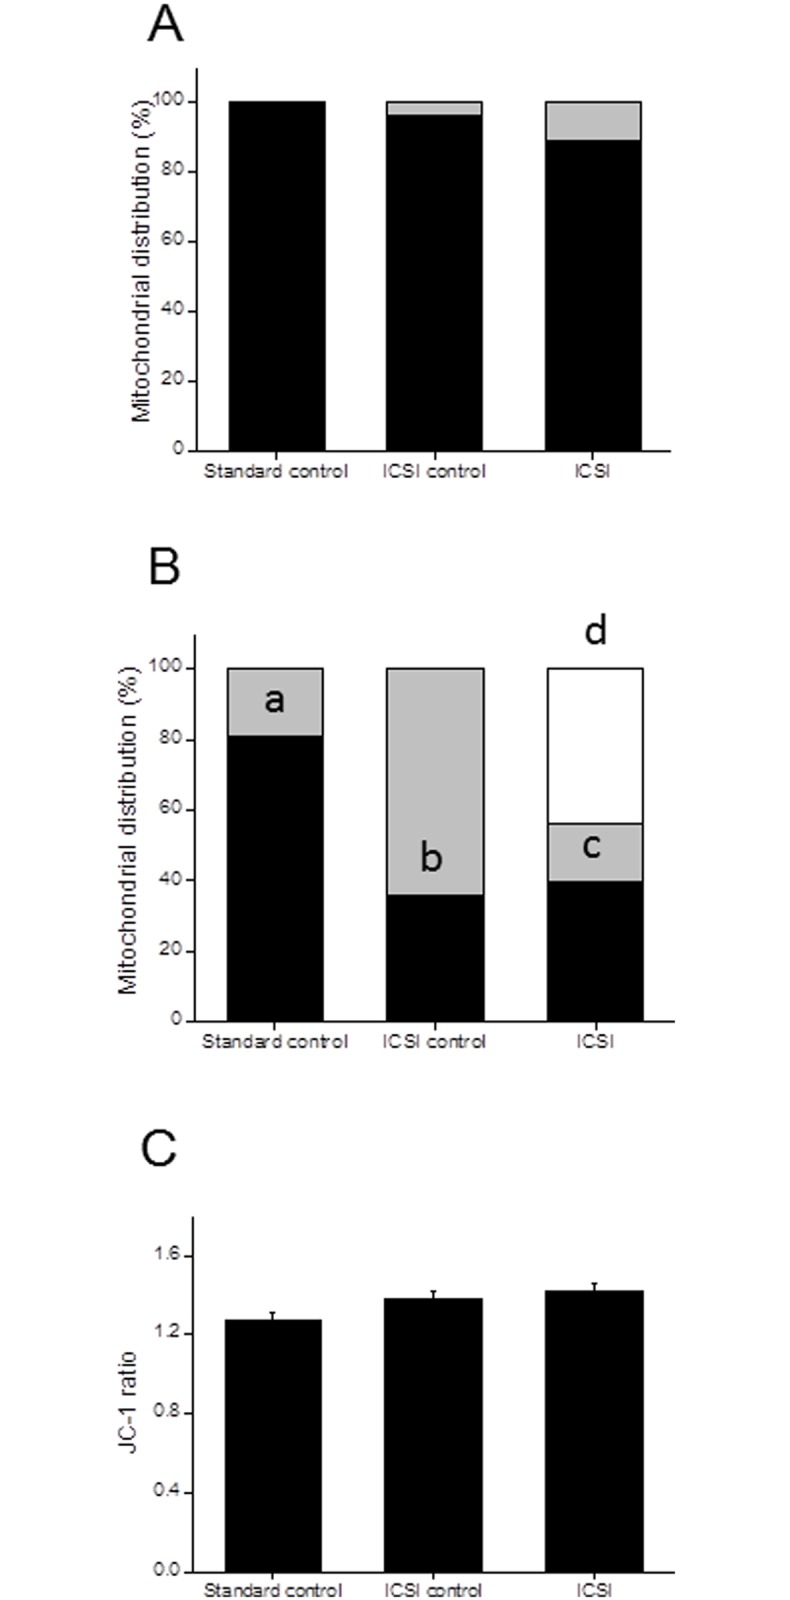
Mitochondrial distribution and activity as measured by Rhodamine 123 and JC1 staining of oocytes.A. Oocytes retrieved from superovulated mice, subjected to mock ICSI were assessed for mitochondrial distribution. The percentage of oocytes displaying uniform (closed bar); and aggregated (grey bar) distribution in standard control (N = 28), ICSI control (N = 49) and ICSI group (N = 36), was determined. B. In vitro matured metaphase II oocytes, subjected to mock ICSI were evaluated for mitochondrial distribution. The percentage of oocytes displaying uniform (closed bar); aggregated (grey bar) and peripheral (open bar) distribution in standard control (N = 33), ICSI control (N = 33) and ICSI group (N = 32), was determined. aP <0.05: Uniform distribution pattern in standard control of figure A Vs Standard control in figure B. bP < 0.001: Standard control Vs ICSI control. cP < 0.01: Standard control Vs ICSI group. dP < 0.0001: percentage of oocytes displaying peripheral distribution in ICSI group with other two groups. C. Mitochondrial activity as measured by the JC1 ratio in IVM oocytes in standard control (N = 81); ICSI control (N = 69) and ICSI group (N = 68). Please note that difference were not significant.